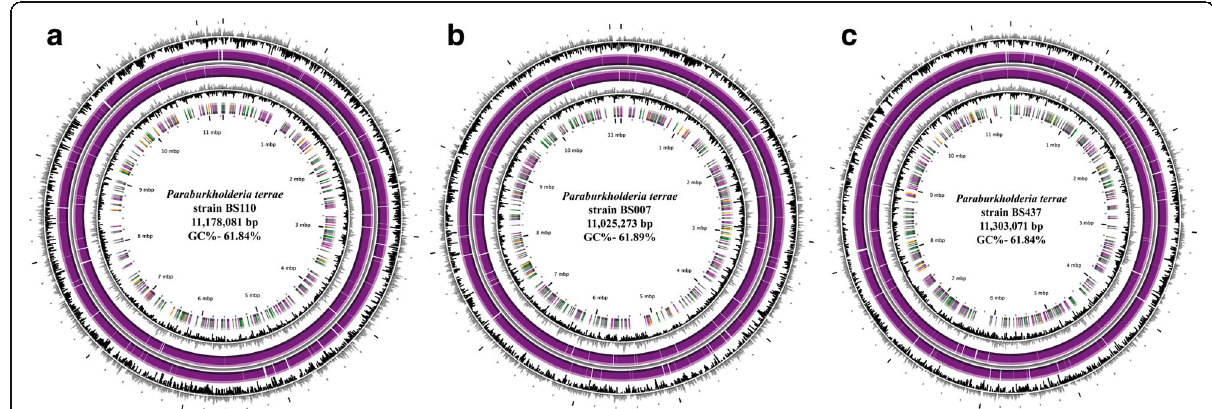
Fig. 3 Circular view of genome sequences (each consisting of several replicons) of Paraburkholderia terrae ( a ) strain BS110, ( b ) strain BS007 and ( c ) strain BS437. The circular display shows, from outside to inside: (i) GC percentage; (ii) Predicted CDSs transcribed in the clockwise direction; (iii) Predicted CDSs transcribed in the counterclockwise direction. (purple colour in (2) and (3) represents Primary/Automatic annotations), (iv) GC skew (G + C/G-C) and (v) color-code representing rRNA (blue), tRNA (green), miscellaneous RNA (orange), Transposable elements (pink) and pseudogenes